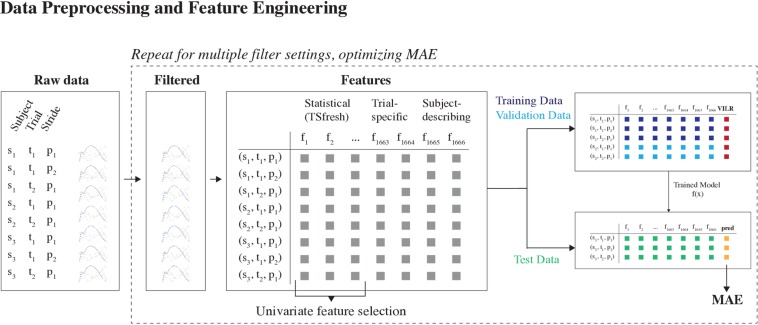
Data preprocessing and feature engineering part of the machine learning pipeline. First, the raw acceleration signals were filtered using a Butterworth bandpass filter. The optimal filter configuration was determined by training multiple models, using different filter configurations. The configuration which enabled the most accurate predictions was used henceforth. Second, feature engineering was used to derive a lower-dimensional representation of the data. The generated features were a combination of automatically generated statistical features and manually crafted domain-specific features. The set of automatically generated features was reduced using a univariate feature selection technique.